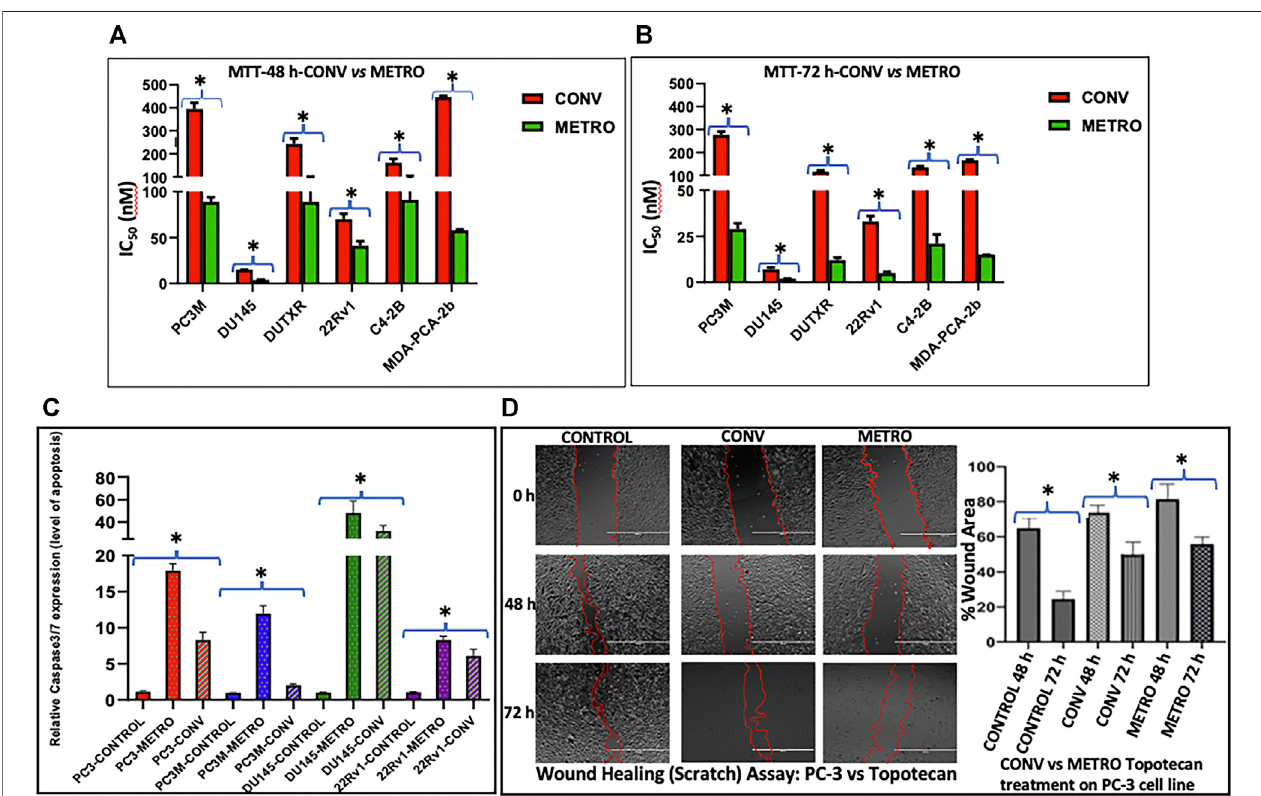
FIGURE 1 | Effect of topotecan on the growth of prostate cells in vitro following Conventional and Metronomic dosing. (A, B) In vitro cytotoxicity. cytotoxicity was assessed following 48 and 72 h of CONV or METRO treatment in PC-3M, DU145, DUTXR, 22Rv1, C4-2B and MDA-PCA-2b cell lines using mitochondrial activity (3-(4, 5- Dimethylthiazol-2-yl)-2,5-diphenyltetrazoliumbromideorMTTassay)atincreasingdrugconcentrations(Signi fi cant p value* (cid:1) p ≤ 0.05). (C) Apoptosisassay.Levelofcaspase3/ 7 enzyme activity measured after METRO and CONV treatment of TOPO for 72 h; METRO-TOPO treatment exhibited higher apoptosis than CONV-TOPO treatment mCRPC/NEPC cell line (PC-3, PC-3M, DU145) and androgen-sensitive 22Rv1. Representative data is shown and similar data was collected for all the cell lines (Signi fi cant p value* (cid:1) p ≤ 0.05). (D) Cellmigration.Woundhealing(Scratch)assayperformedbymeasuringcellmigration,invasionandgrowthafterMETROandCONVtreatmentofTOPO for 48 and 72 h. METRO-TOPO treatment exhibited reduce wound healing than CONV-TOPO treatment mCRPC cell line (PC-3) (Signi fi cant p value * (cid:1) p ≤ 0.05).